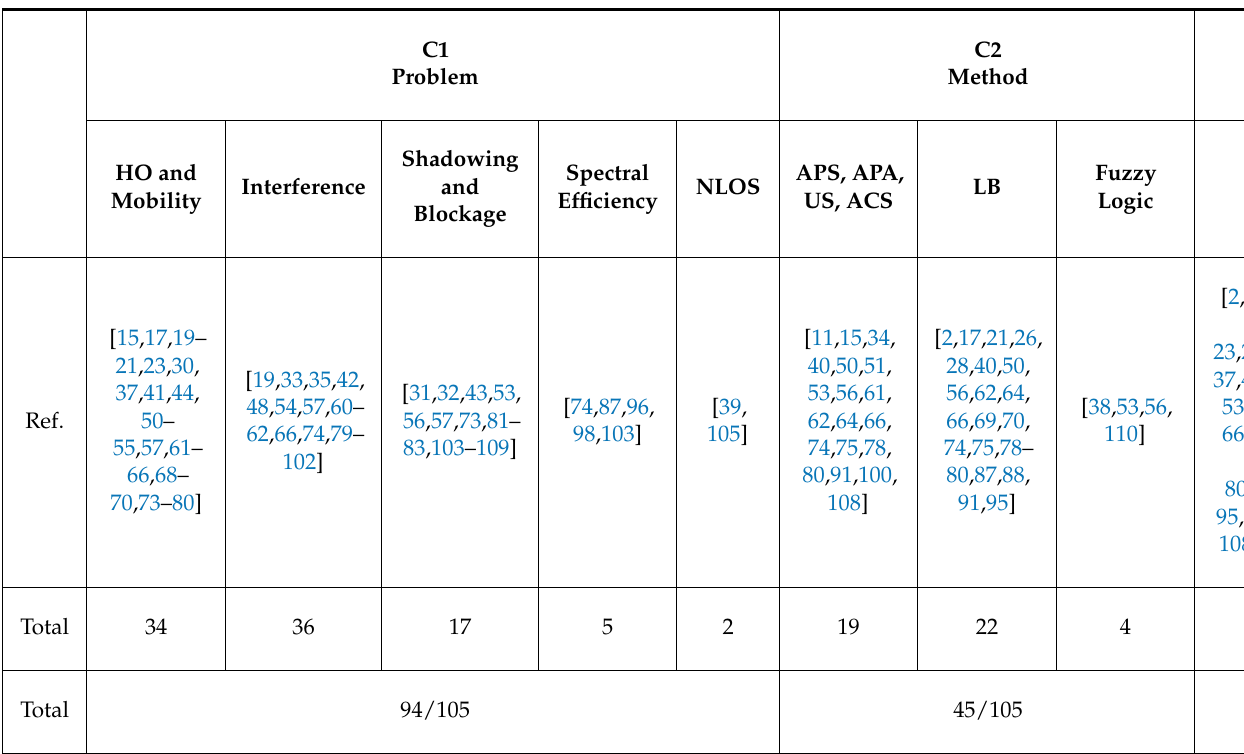
Table 1. Classification statistics of simulation studies based on multiple